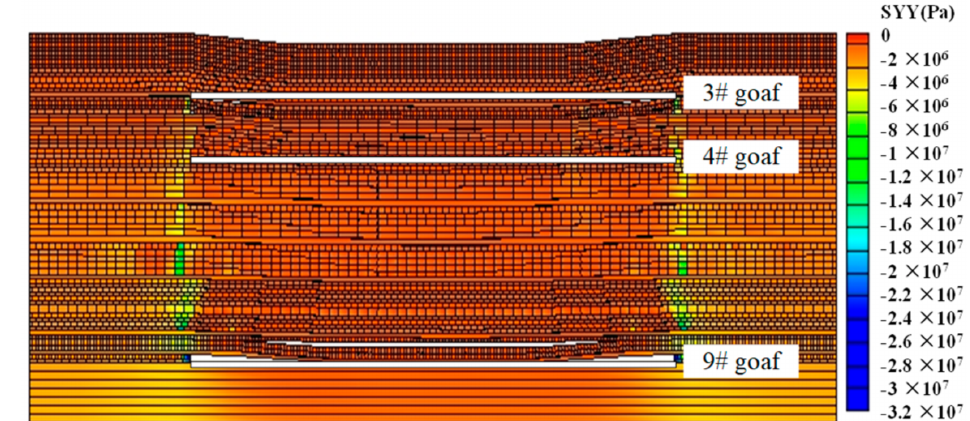
Figure 20. Stress field diagram of overburden after the mining of the 9# coal seam.